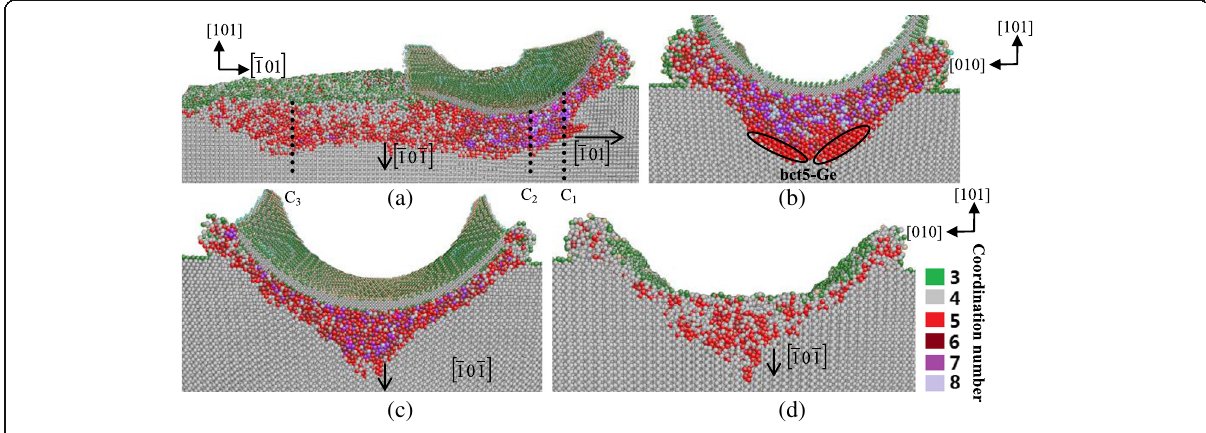
Fig. 8 Cross-sectional views of the subsurface deformation when nano-cutting along the 101 passing through the middle of the tool. b On the 101 plane, passing through C